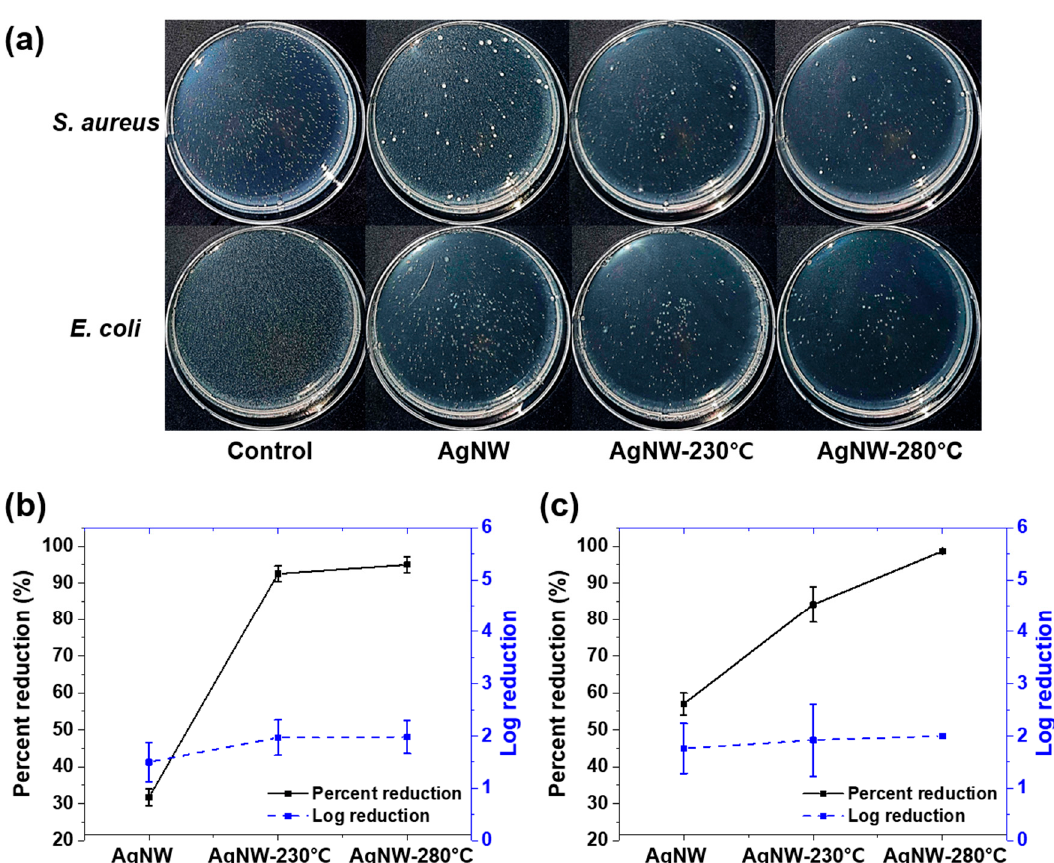
Figure 3. ( a ) Top-view photos of incubated agar-plates and antibacterial activity of AgNW, AgNW-230 ◦ C, and AgNW-280 ◦ C against ( b ) S. aureus and ( c ) E. coli. The bacterial tests were performed by contacting the sample with an inoculum containing 4 × 10 6 CFU of test bacterial strains for 30 min.